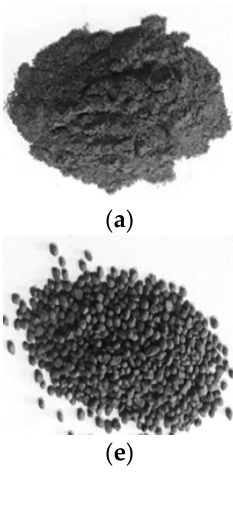
Figure 1. Type of self-healing solid capsules: ( a ) 75 μ m, ( b ) 150 μ m, ( c ) 300 μ m, ( d ) 600 μ m, ( e ) 850 μ m, ( f ) 1200 μ m, and ( g ) 2400 μ m.